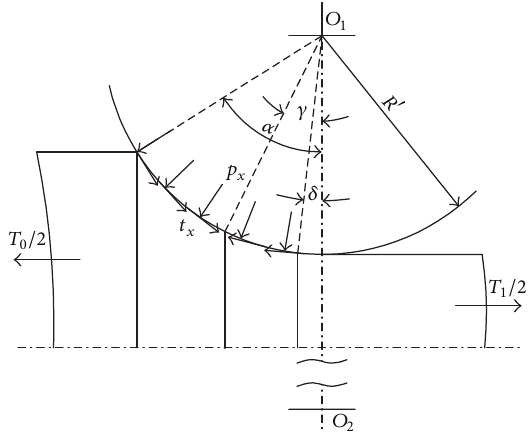
Figure 4: Equilibrium of force system in the roll